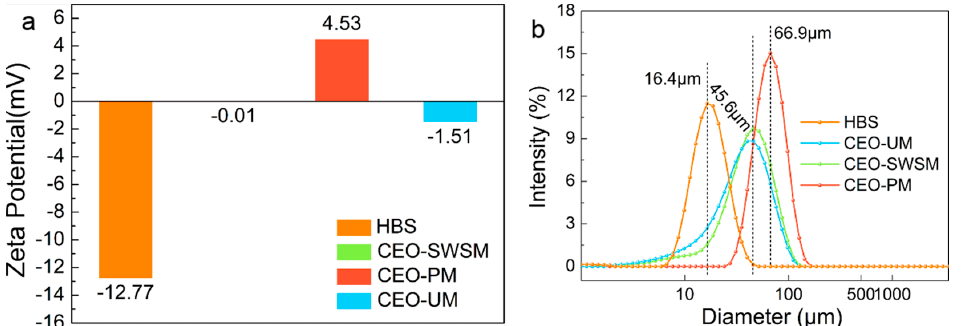
Figure 3. ( a ) Zeta-potential values and ( b ) size distributions of HBS and the CEO-SWSM, CEO-PM, and CEO-UM microcapsules determined by DLS.